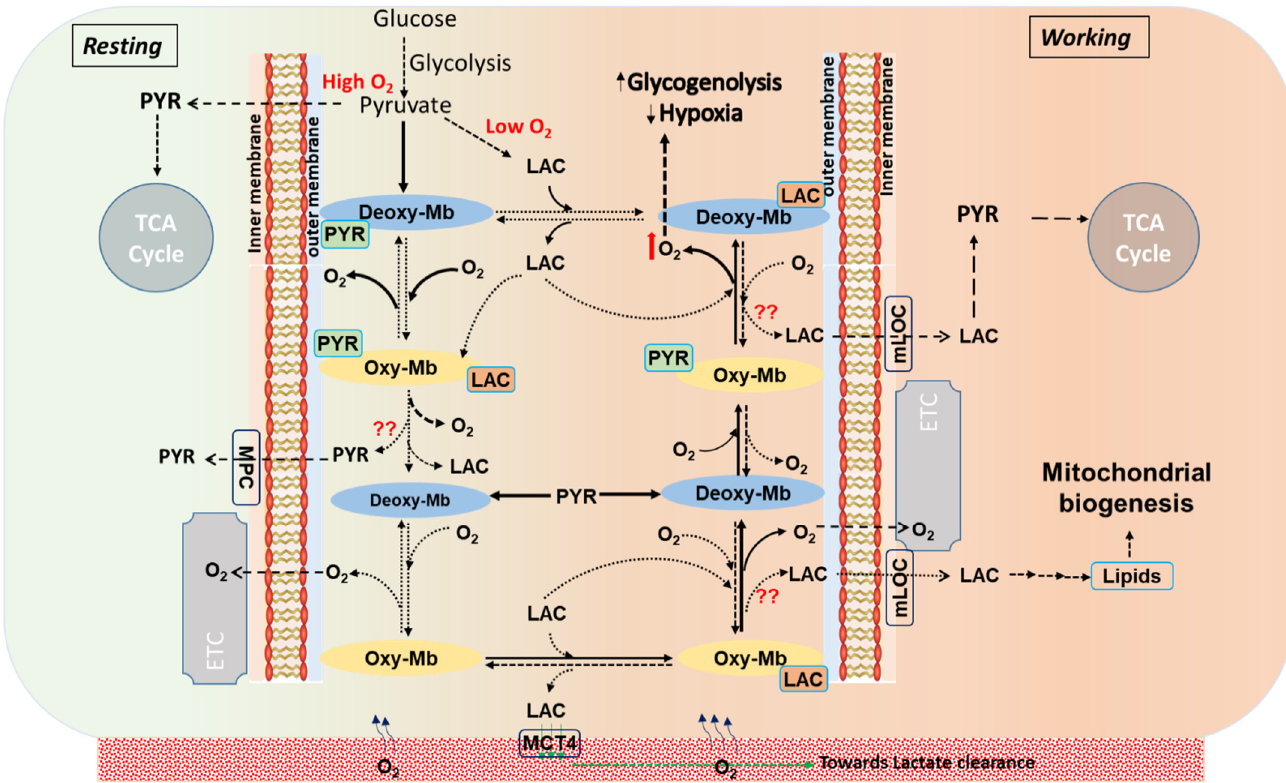
Figure 5. A schematic representation displays the stoichiometric turnover events on conversion of oxy-myoglobin (oxy-Mb) to deoxy-myoglobin (deoxy-Mb) and vice versa in metabolite-bound Mb states in a normal aerobic cell (resting) at constant supply of diffused oxygen (O 2 ), or in working muscle characterized by reduced pO 2 and lower pH. In resting conditions (displayed in light green color background, leftward), aerobic glycolysis generates PYR that avidly binds to deoxy-Mb (shown in solids arrows). Similarly, LAC (end-product of anaerobic glycolysis), increasingly generated as workload increases and pO 2 drops (displayed in light red color background, rightward), binds avidly to oxy-Mb, but does not bind to deoxy-Mb [32] . However, in working muscle cells and at elevated lactic acid (LAC) levels (>1.0 mM), although PYR binds to both oxy-Mb and deoxy-Mb with low binding affinities, LAC strongly binds to Mb in acidic conditions and releases O 2 from oxy-Mb [32] . In all these proposed events, release of Mb-bound PYR/LAC is not clearly known. Solid arrows ( ) display high affinity and rapid reaction rates and dashed arrows ( ) display lower affinity and slower reaction rates. oxy-Mb: oxygenated-Mb; deoxy-Mb: deoxygenated-Mb; PYR: pyruvate; LAC: lactate; TCA cycle: tricarboxylic acid cycle; ETC: electron transport chain; MPC: mitochondrial pyruvate complex; mLOC: mitochondrial lactate oxidation complex; MCT4: monocarboxylate transporter 4.